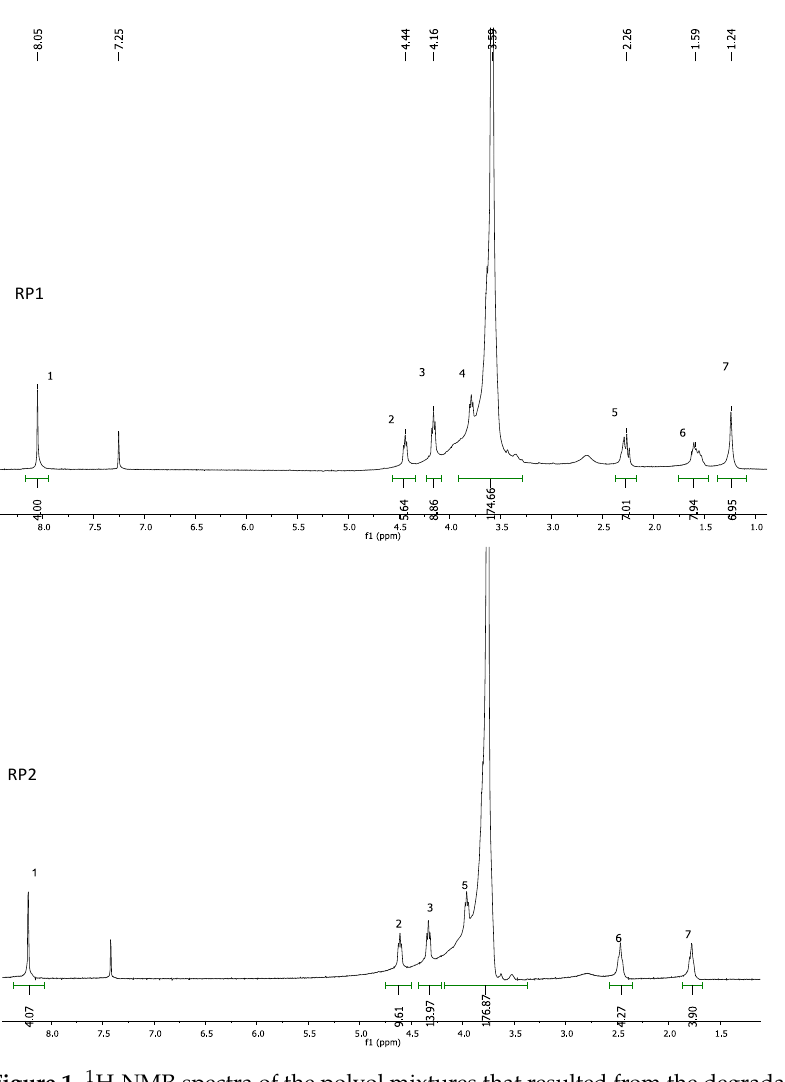
Figure 1. 1 H-NMR spectra of the polyol mixtures that resulted from the degradation of PET.